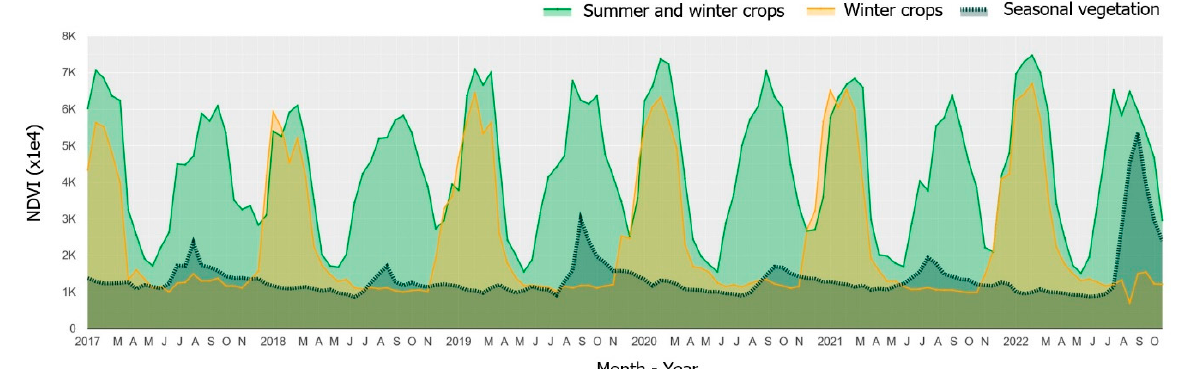
Figure 9. Yearly average MODIS NDVI trends (2017–2022) in three environments within the Cholistan region. Note the peak in seasonal vegetation following the 2022 ephemeral desert bloom.